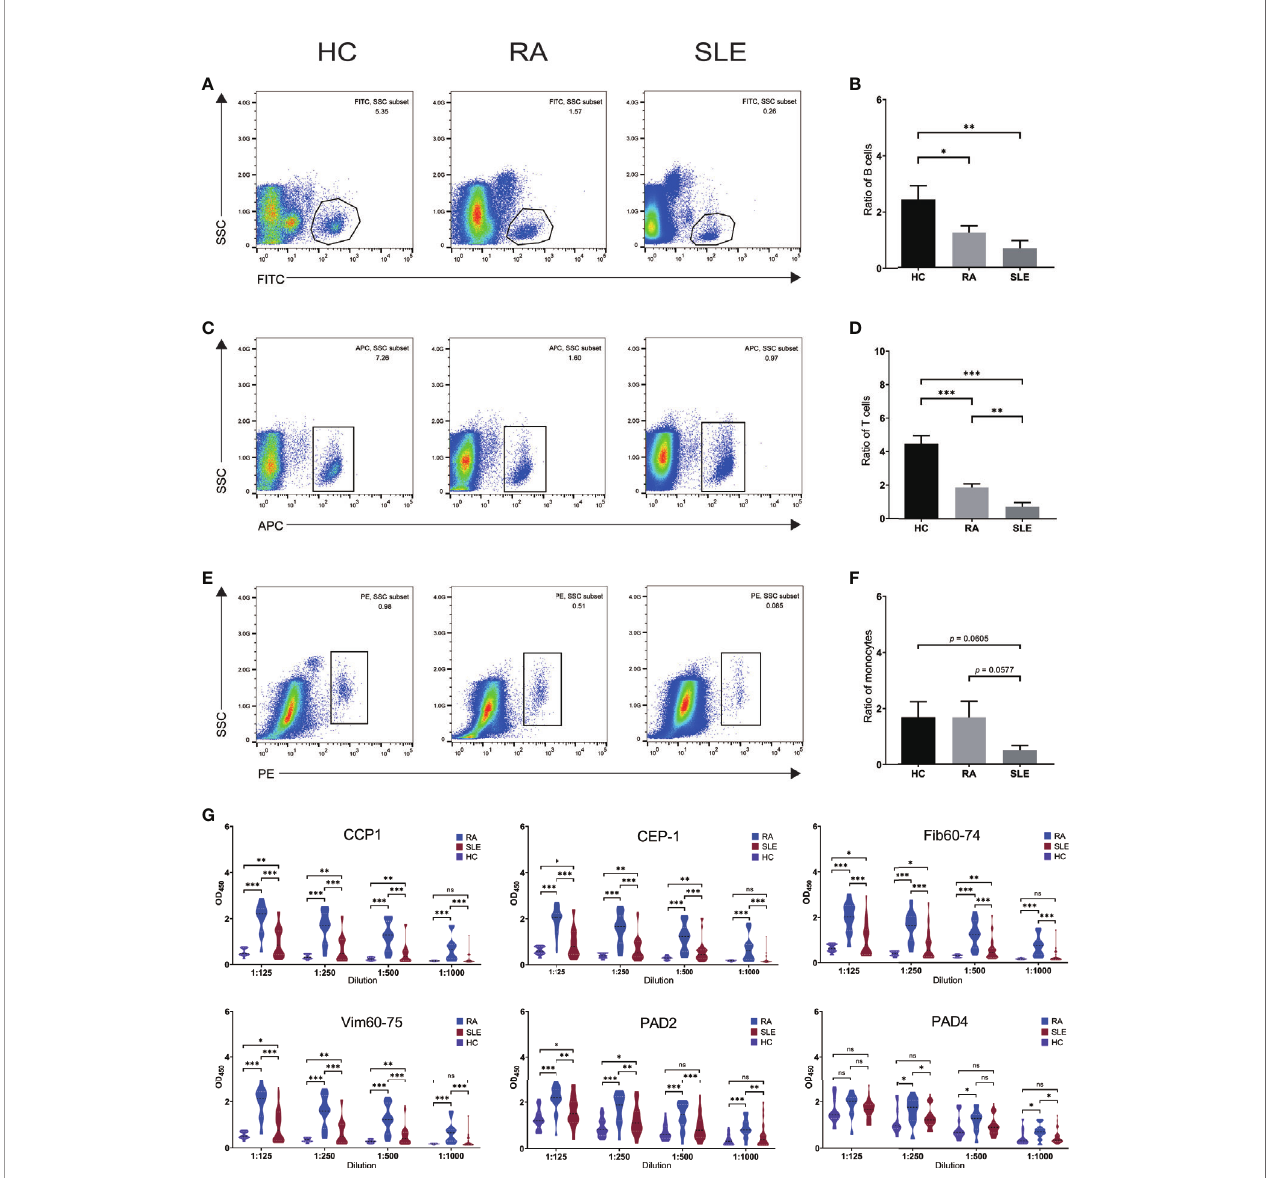
FIGURE 1 | Number of immune cells and level of anti-citrullinated peptide/protein antibodies in the sera of RA, SLE and healthy blood donors. (A, C, E) Flow cytometry sorting results for CD19 + B- and CD4 + T- cells and, CD14 + monocytes in HC, RA and SLE. (B, D, F) Ratio of CD19 + B-, CD4 + T- cells and, CD14 + monocytes in HC, RA, and SLE. (G) The level of anti-CCP1, anti – CEP-1, anti – Fib60-74, anti – Vim60-75, anti-PAD2/4 IgG antibodies in HC, RA, and SLE sera. ns, not signi fi cant. *p < 0.05; **p < 0.01; ***p <